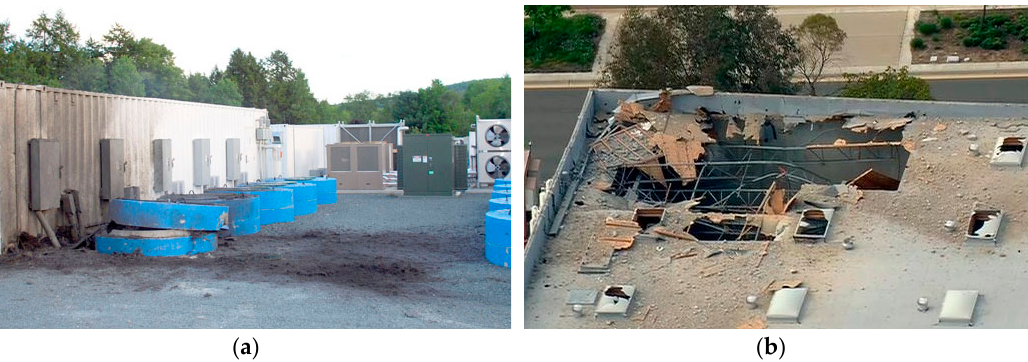
Figure 2. ( a ) Impressions of the accidents at Beacon Power in Stephentown [8]; ( b ) Quantum Technologies flywheel-plant in San Diego, USA [9].